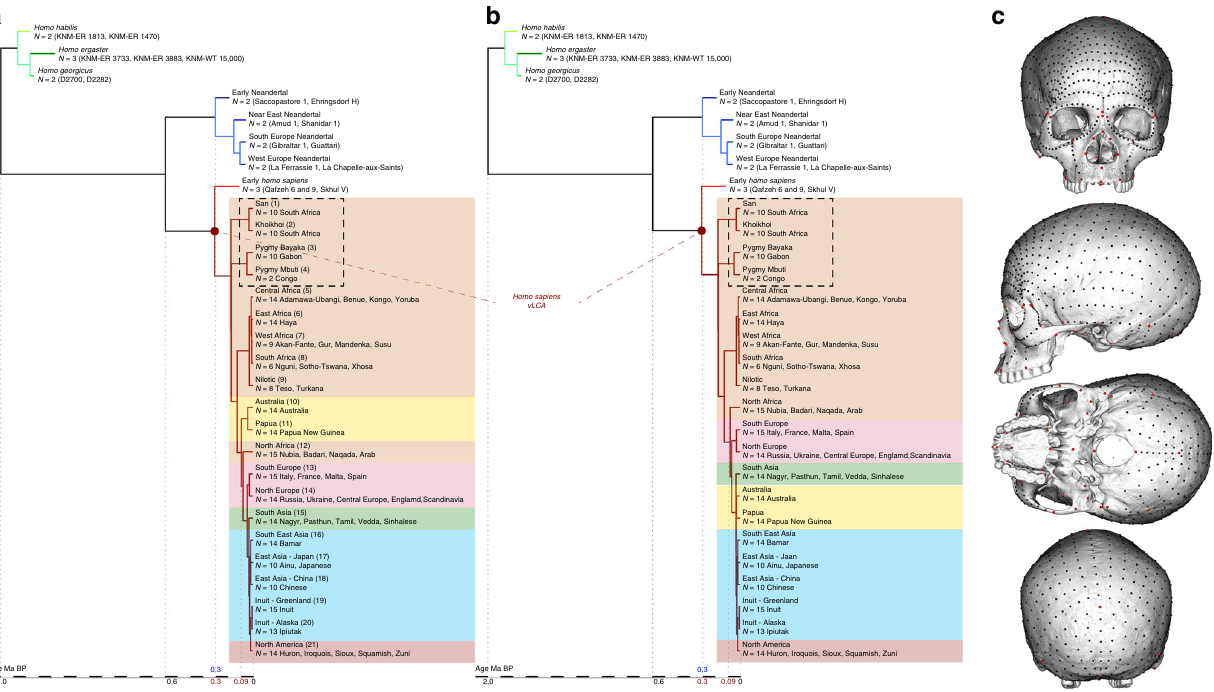
Fig. 1 Phylogenetic hypotheses and landmarks distribution on the cranium. a and b Fully resolved phylogeny of the genus Homo according to hypotheses 1 ( a ) and 2 ( b ). c Position of the 780 landmarks and semilandmarks used in the study to describe the crania of the phylogeny